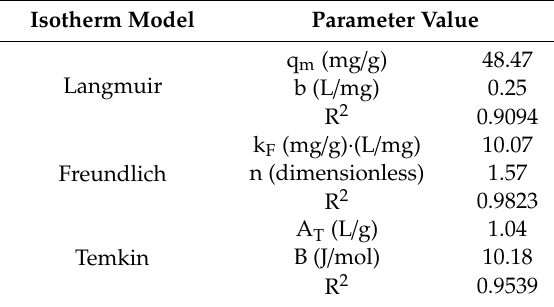
Table 1. Parameters and correlation coe ffi cients obtained from fits of the isotherm models to the experimental